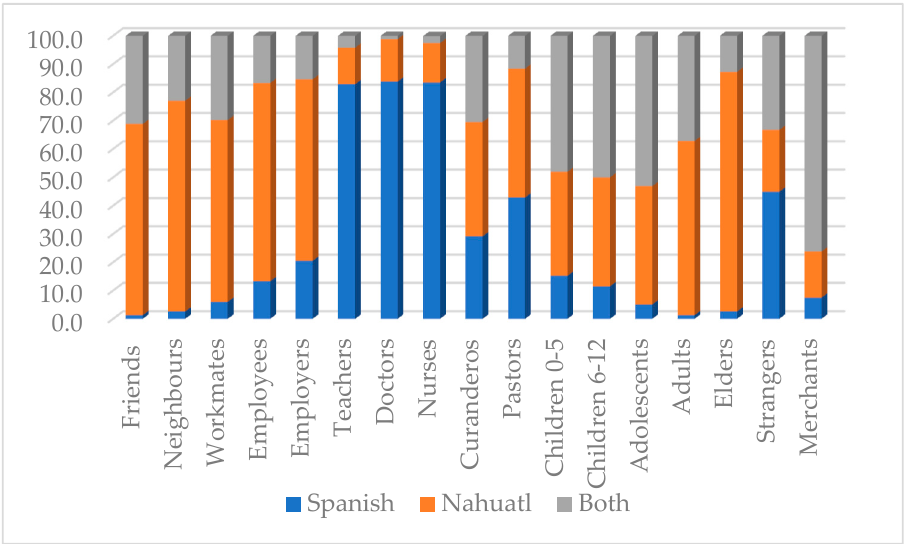
Figure 4. Language use in the community by adults (in percentages).